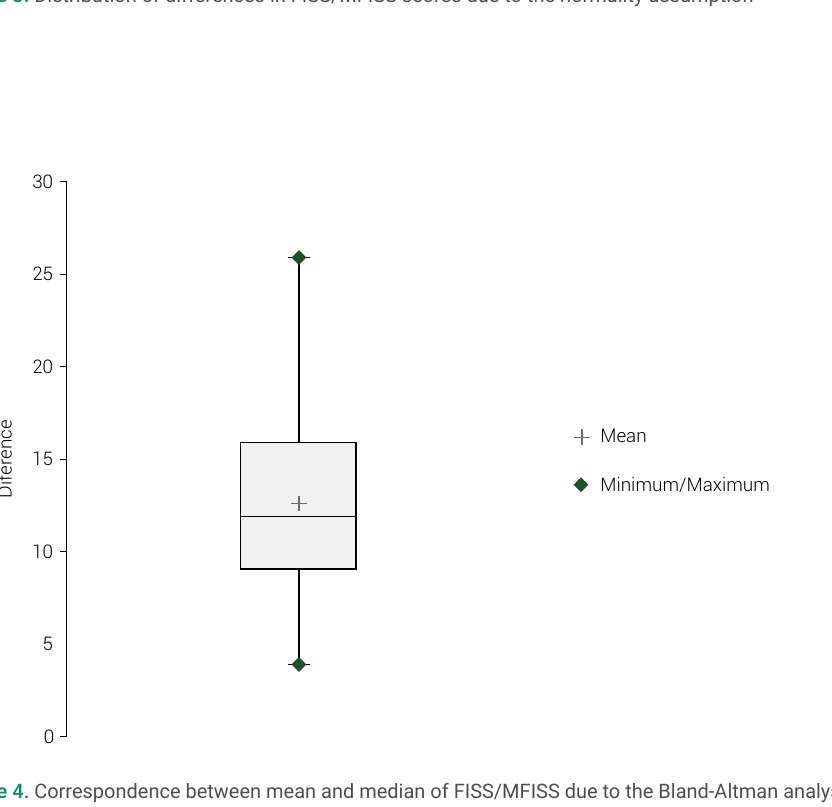
Figure 3. Distribution of differences in FISS/MFISS scores due to the normality